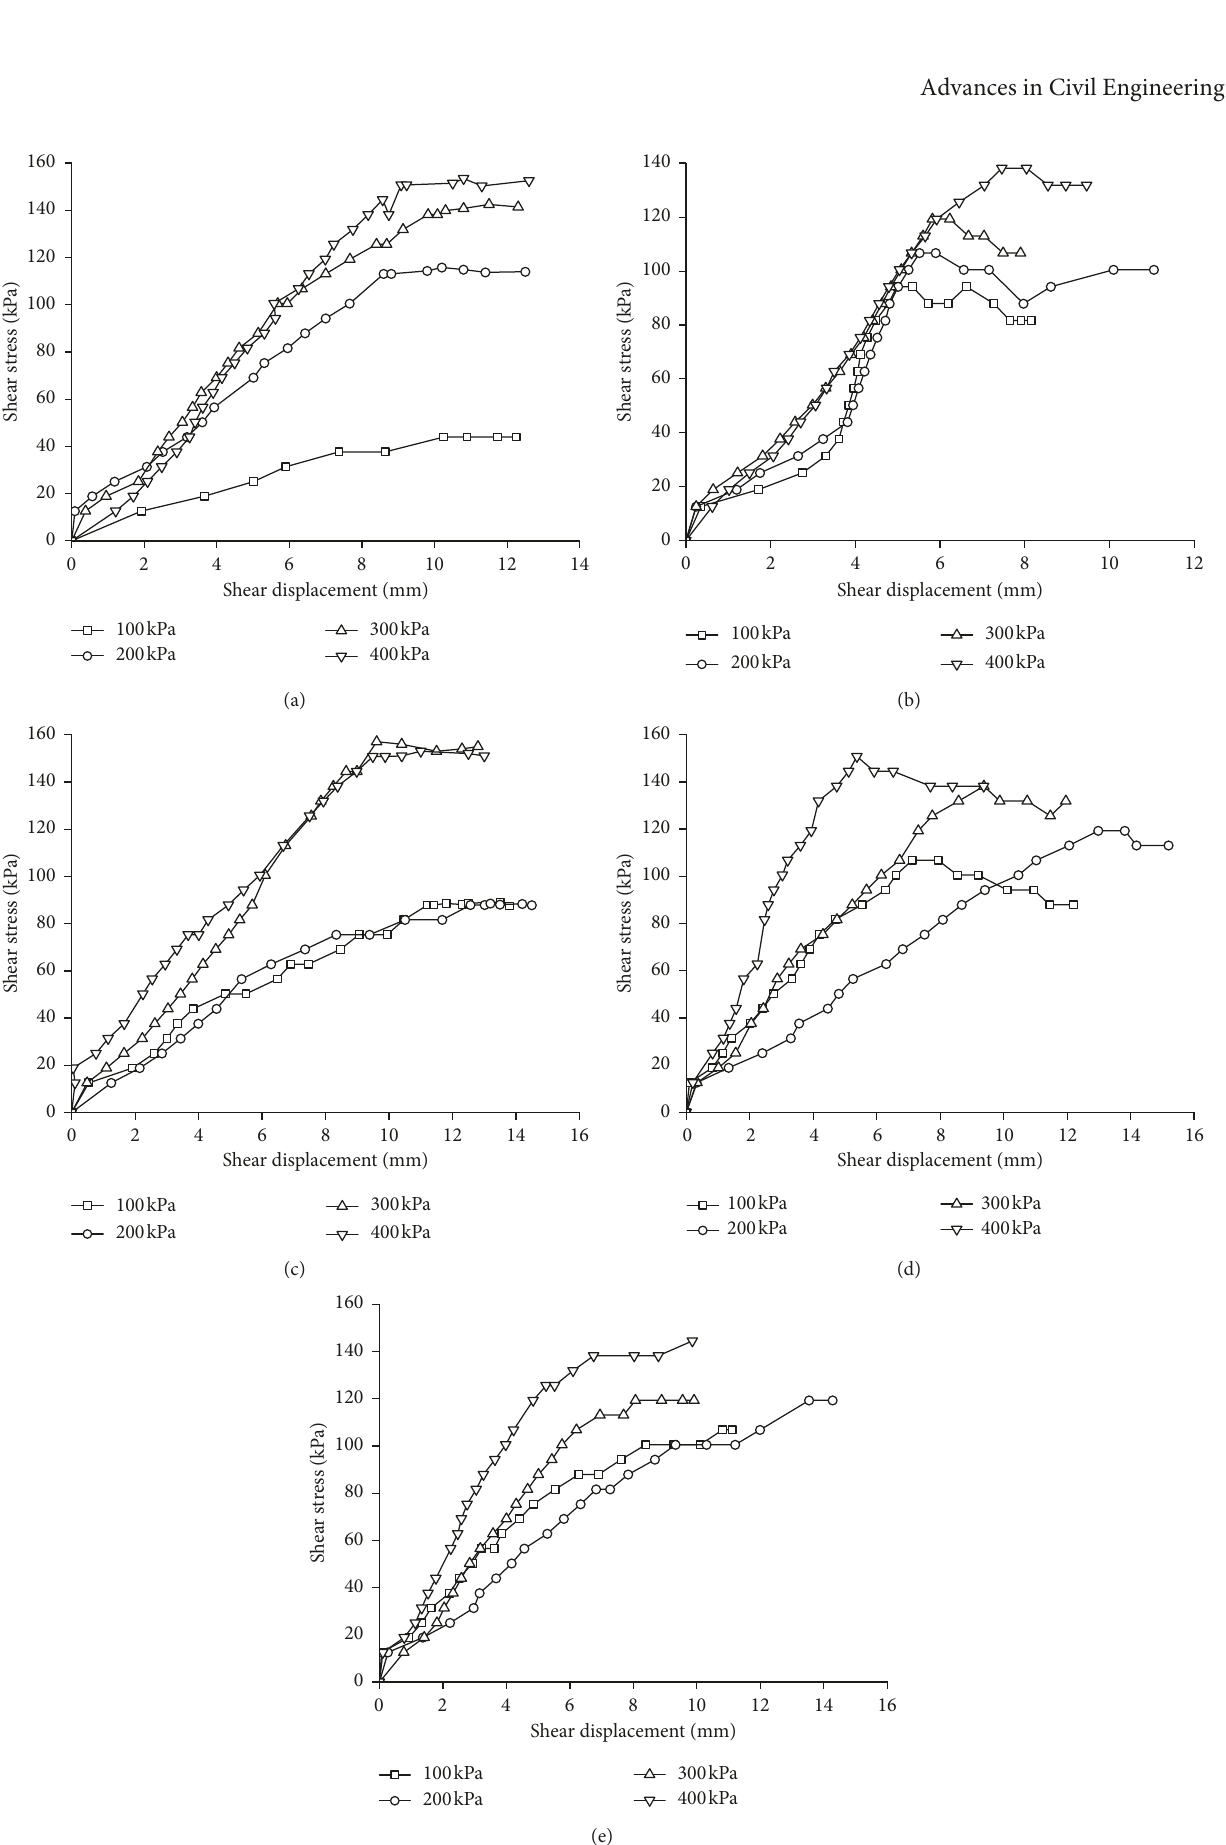
Figure 14: Curves of shear stress and shear displacement in different angles of macropore structure. (a) 0 ° , (b) 15 ° , (c) 25 ° , (d) 35 ° , and (e) 45 °